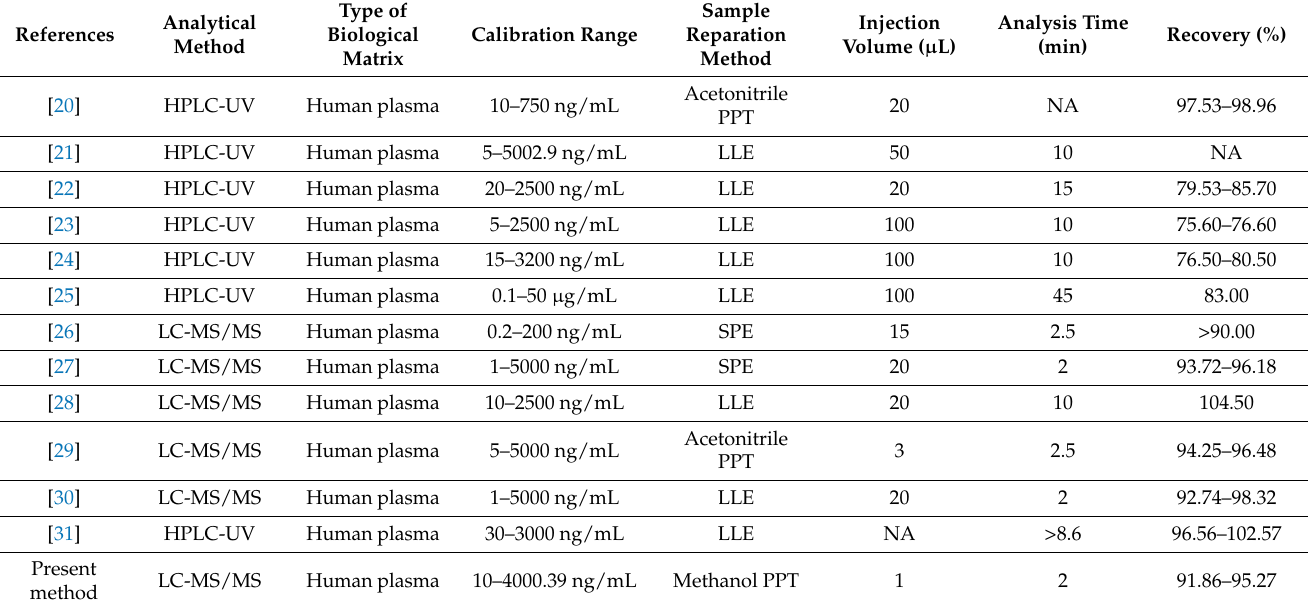
Table 1. Summary of published bioanalytical methods for the quantification of etoricoxib in biological